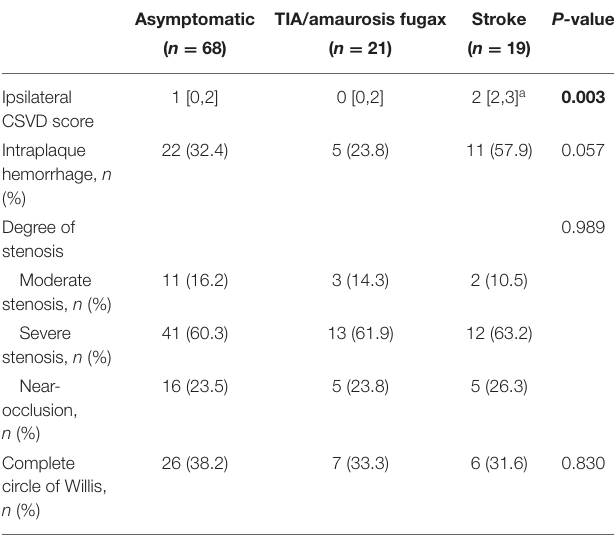
TABLE 3 | Comparison of imaging markers between groups with different clinical symptoms. Asymptomatic TIA/amaurosis fugax Stroke P-